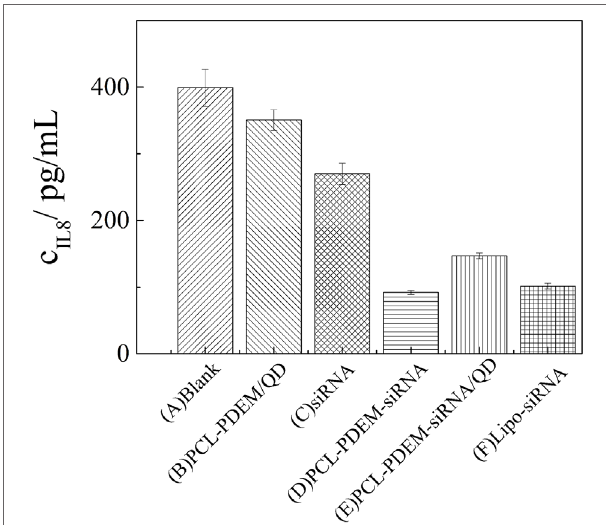
FIGURE 9 | IL-8 expression levels in SK-Hep1 cells were assayed by ELISA. (A) Blank, (B) PCL-PDEM/QDs, (C) siRNA, (D) PCL-PDEM-siRNA, (E) PCL- PDEM-siRNA/QDs, and (F) Lipo-siRNA. Values are mean ± SD, n =